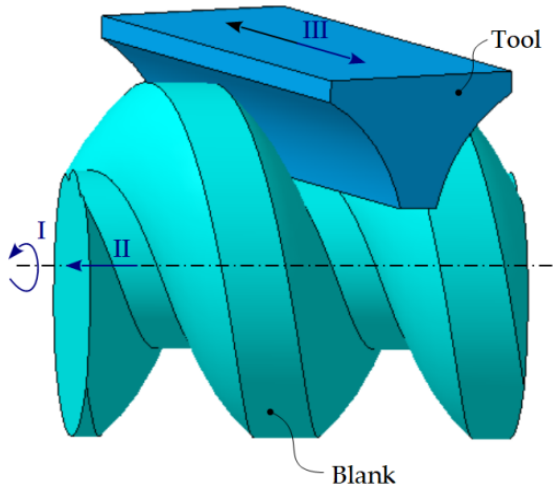
Figure 20. The kinematic principle of generating: I represents the rotational movement of the blank, II — the translational movement of the blank along its own axis, III — the cutting movement performed by the tool.